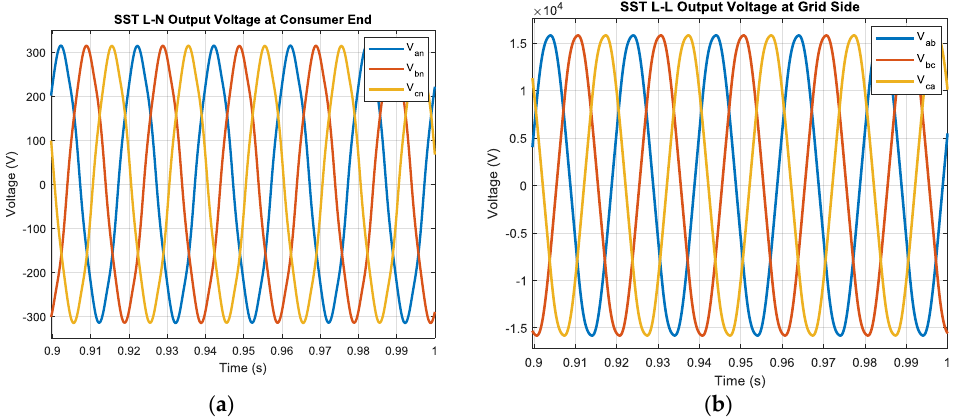
Figure 22. SST simulation results when integrated with renewable energy resource. ( a ) SST line to neutral voltage at the consumer end. ( b ) SST line to line voltage at the grid end.